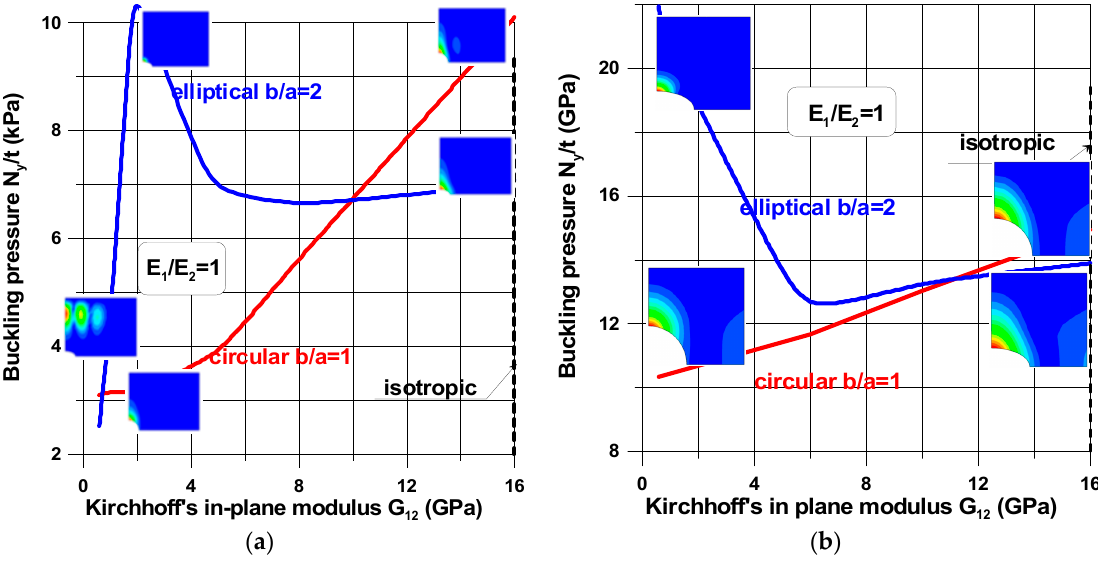
Figure 6. The influence of in-plane shear properties on buckling loads; ( a ) a rectangular plate, L x / L y = 1.25, 2 b / L x = 0.16; ( b ) a square plate, 2 b / L x = 0.4.